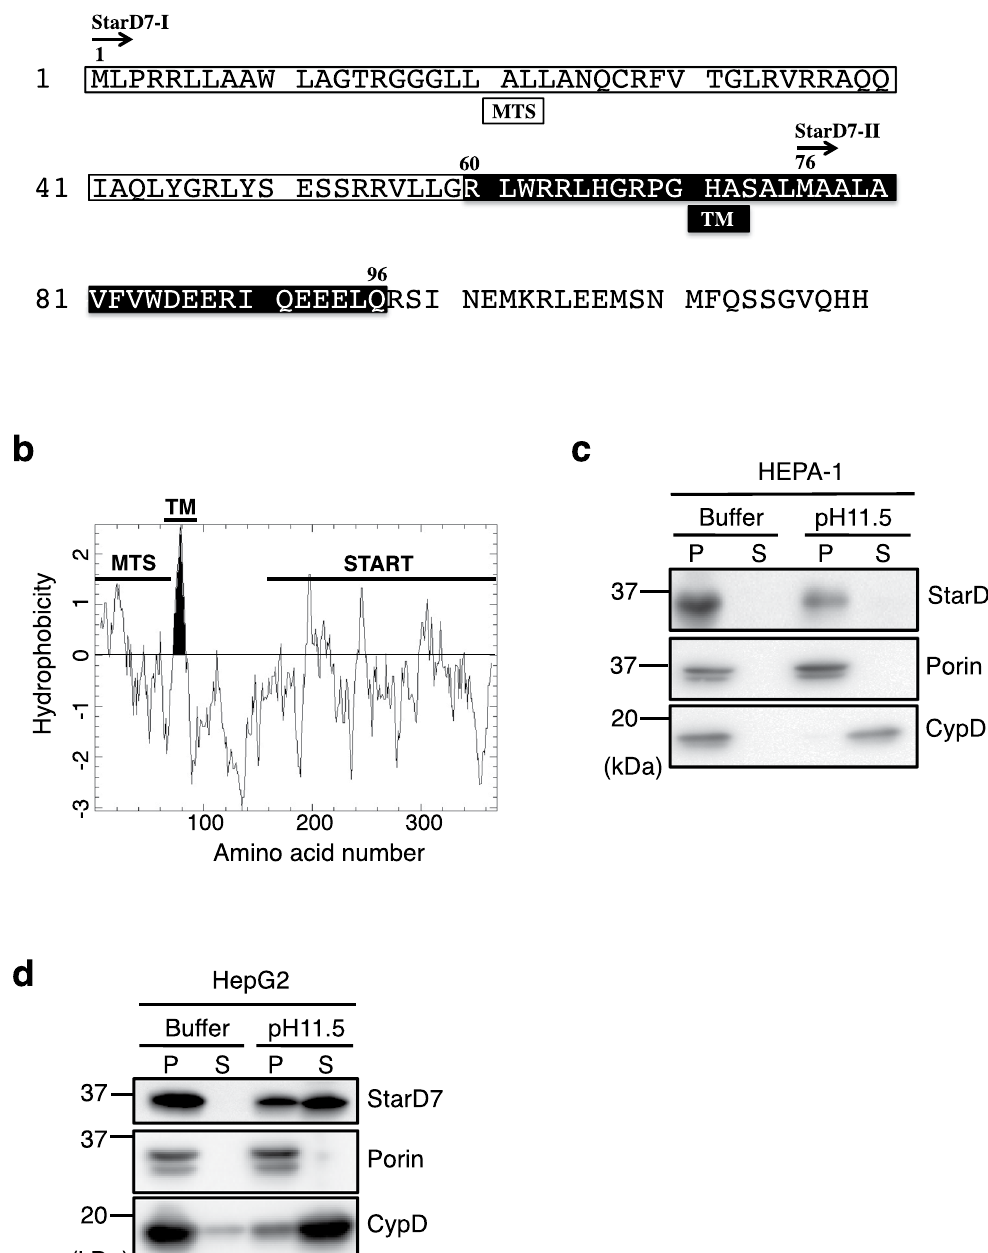
Figure 1. Endogenous StarD7 in HEPA-1 cells and HepG2 cells is integrated into the mitochondrial membrane. ( a ) The N-terminal amino acid sequence of StarD7. StarD7-I and StarD7-II start from Met 1 and Met 76 , respectively. The putative mitochondrial-targeting signal (MTS) (Met 1 -Gly 59 ) is boxed . The putative transmembrane (TM) domain (Arg 60 -Gln 96 ) is indicated by white letters in the black box . ( b ) Hydrophobicity plot of human StarD7 as determined by Kyte-Doolittle prediction. The putative TM domain is indicated by shading the peak black . ( c and d ) Alkaline extraction assays for HEPA-1 ( c ) and HepG2 ( d ) cells. Mitochondria isolated from the cells were treated with isotonic buffer (Buffer) or alkaline buffer (pH 11.5), and then the pellet (P) and supernatant (S) were separated by centrifugation. The membrane and soluble fractions were dissolved in the same volume of sample buffer, and the same volume of protein solutions were separated by SDS-PAGE and analyzed by Western blotting with anti-StarD7, porin, and CypD antibodies. Porin is a membrane-integrated protein and CypD is a matrix